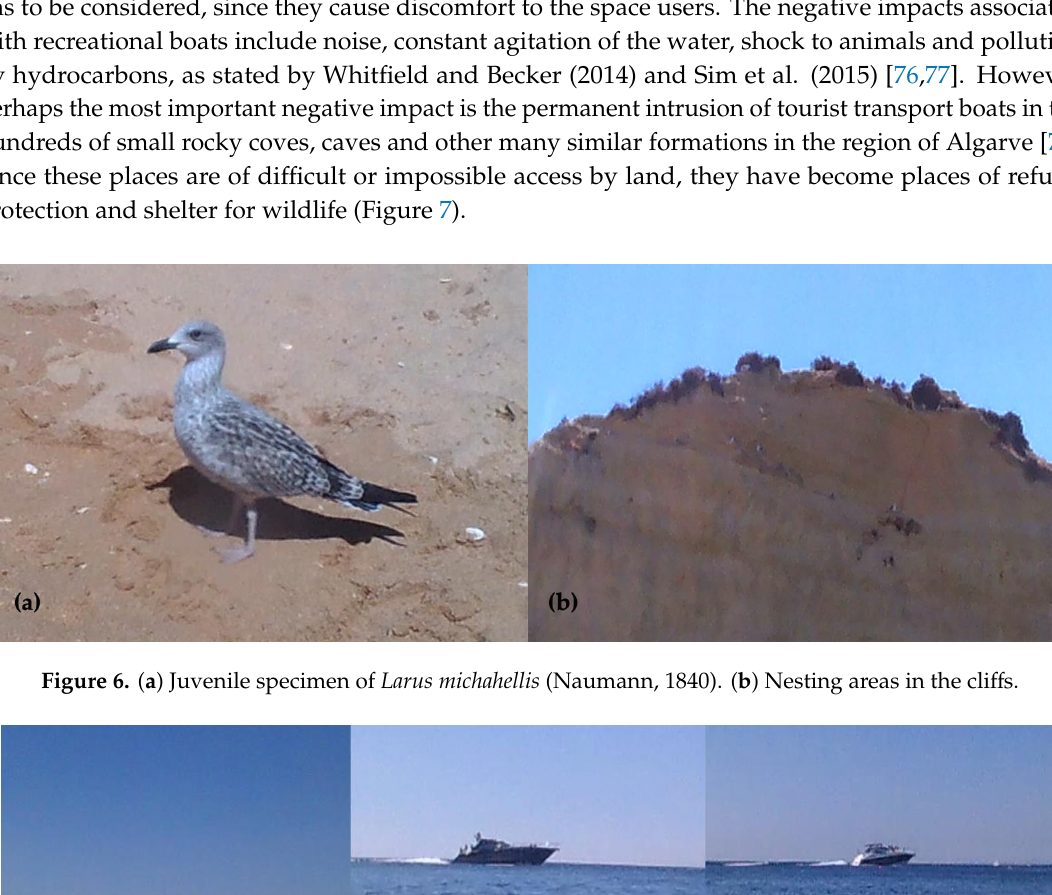
Figure 7. Continuous flow of pleasure boats and tourist transportation for visiting the caves along the rocky coast of Lagoa, Silves and Albufeira. These three vessels were photographed within 5 min, moving at great speed and less than 100 m from the beach, making the engine noise very audible.